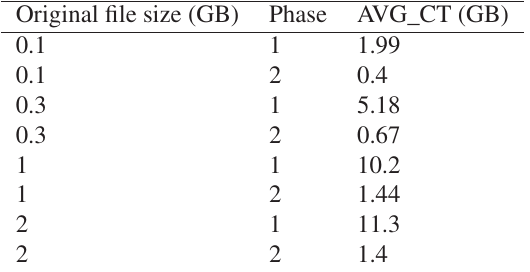
Table 1. Estimated average concurrent tra ffi c within the first experiment.